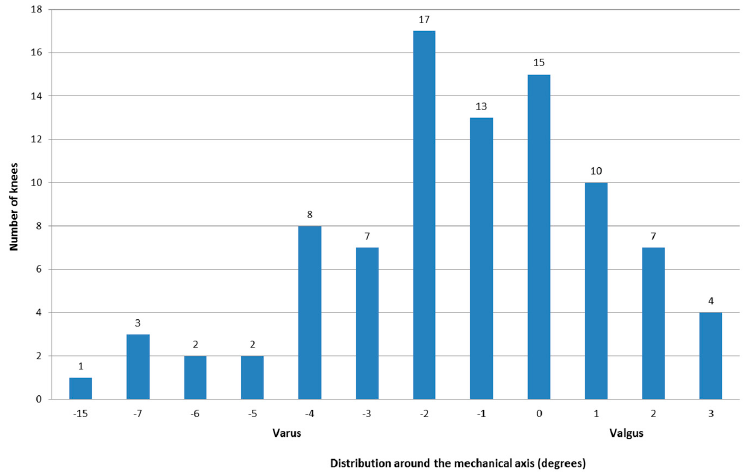
Figure 2. Bar graph depicting the distribution of the post-operative alignment around the mechanical axis. Negative values indicate varus alignment, and positive values represent valgus alignment. Table 1. Mean ± standard deviation of pre- and post-operative radiographic measurements among aligned and outlier TKAs.